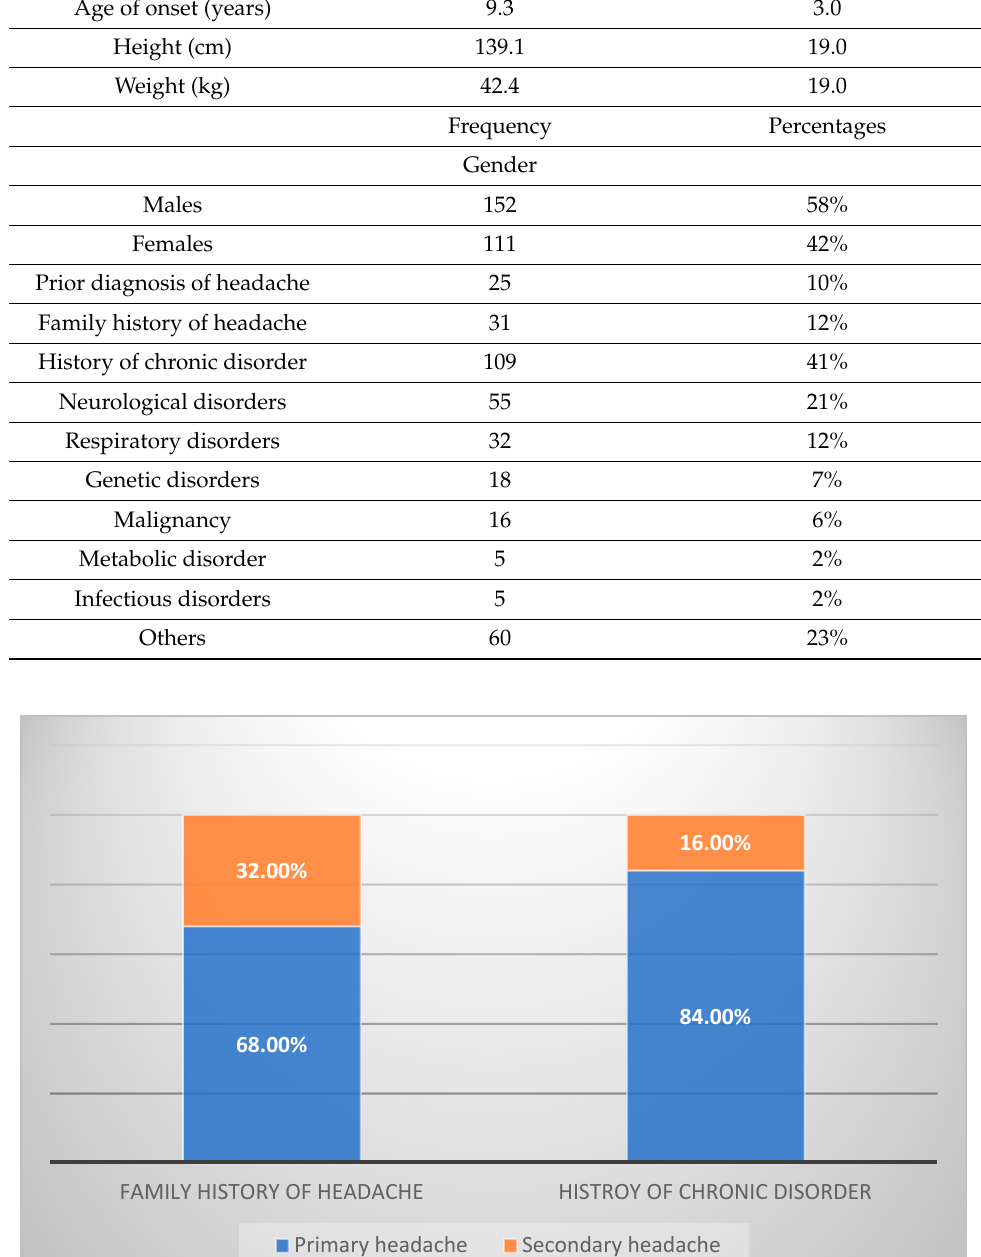
Table 1. Basic demographics of children presenting to the ER with headache (n = 263).